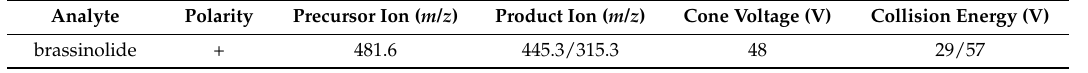
Table 1. The reaction monitoring conditions for protonated brassinolide ([M + H] +